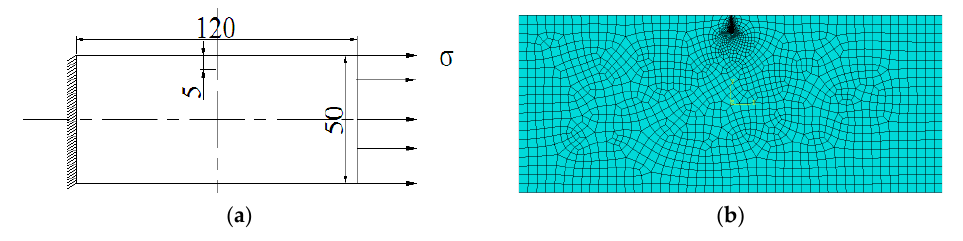
Figure 1. ( a ) Edge crack mode, and ( b ) developed numerical model. Table 1. Major material properties of 7057T6 high strength aluminum alloy.